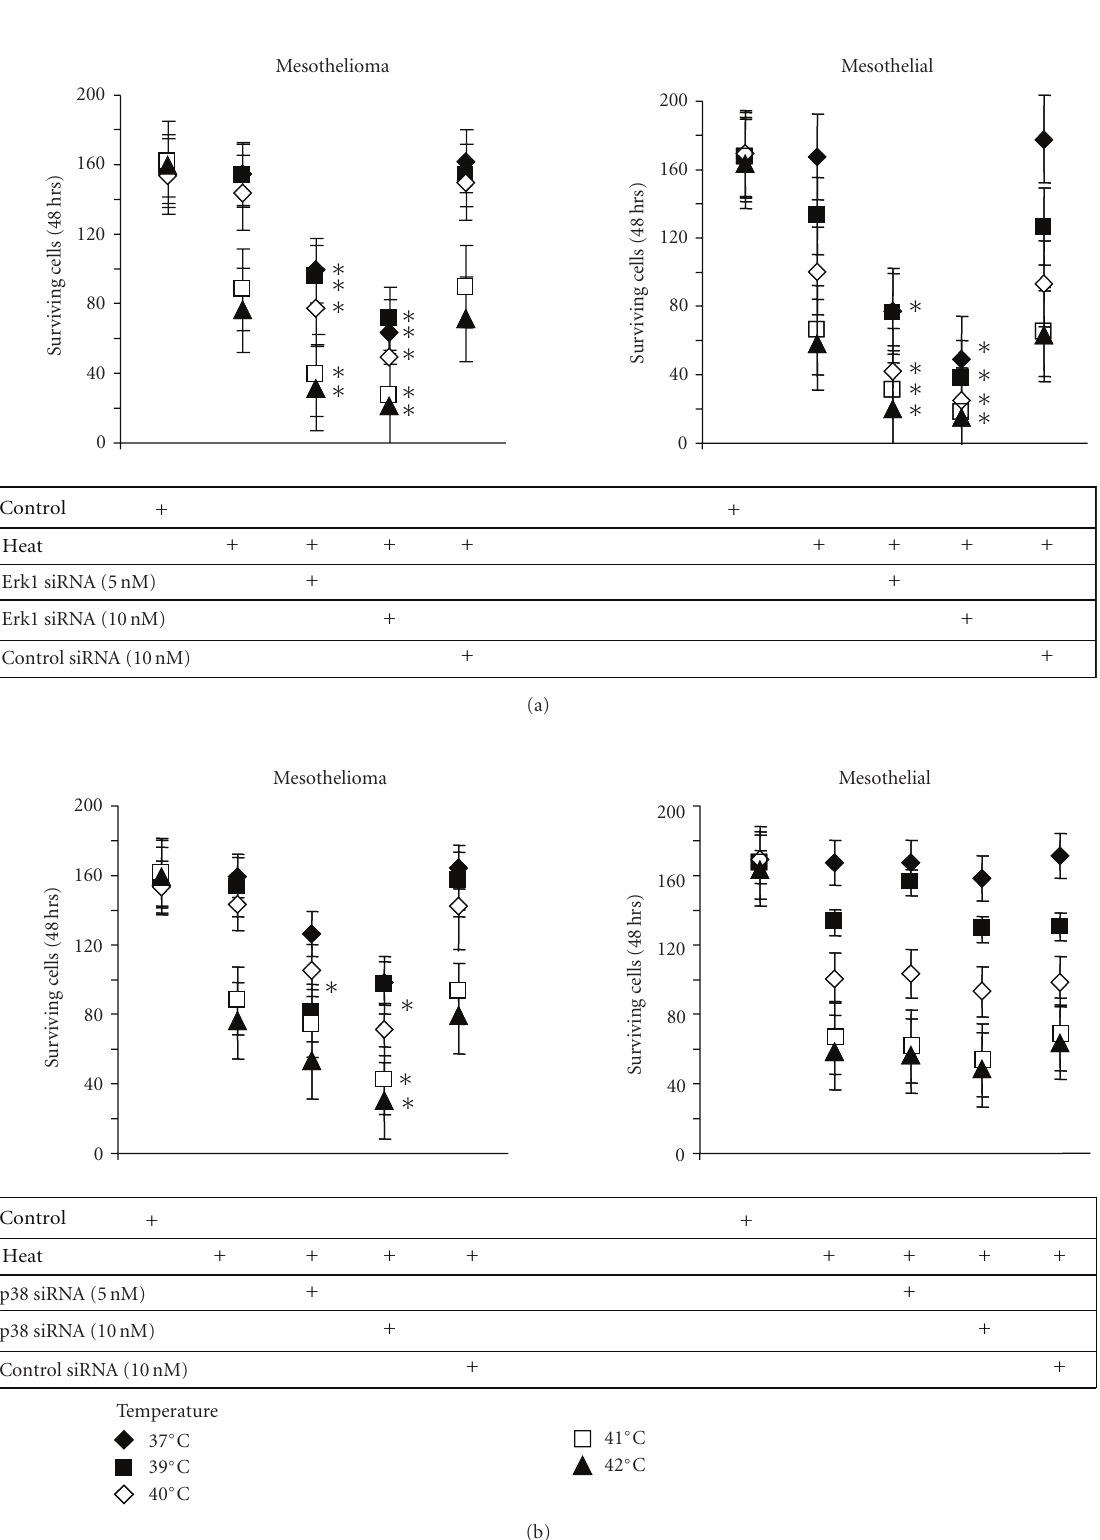
Figure 4: The role of Erk1/2 and p38 MAPK in heat stress-induced cell death in PDMM and mesothelial cells. (a) Cell were pre-incubated with 5 or 10nM of Erk1 MAPK small inhibitory (si)RNA and then exposed to various temperatures (39–42 ◦ C) for 20 minutes. Following cells were kept under normal growth conditions for 48 hours and viable cells were counted by trypan blue exclusion staining. (b) Cells were preincubated with 5 or 10 nM of p38 MAPK siRNA as described above (a) and viable cells were counted after trypan blue exclusion staining. Data points represent the mean ± S.E.M. of triplicate experiments. ∗ indicates P < . 01 (student’s paired t -test,